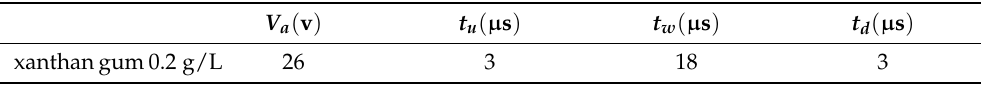
Figure 8. Diagram of single trapezoidal driving waveform. Table 2. Characteristics of the origin driving waveform.